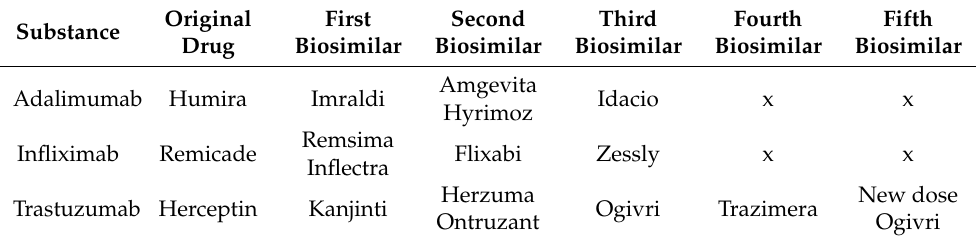
Table 1. Drugs selected for this